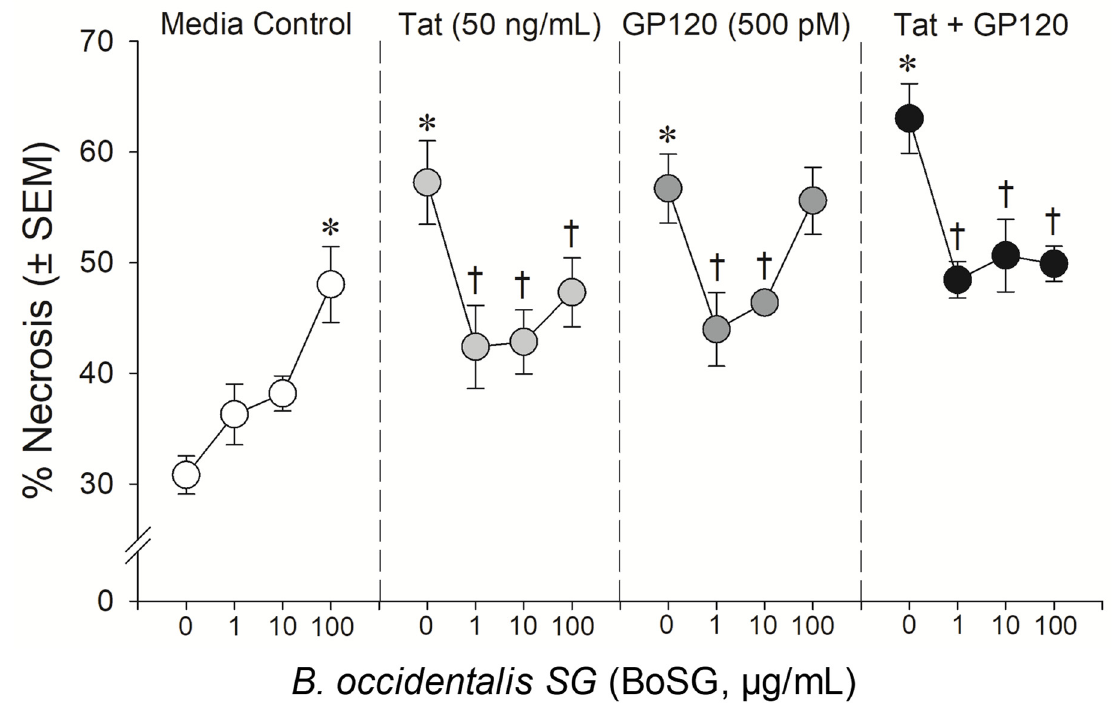
Figure 3. Neuronal cell death among C57BL/6N, striatal, medium spiny neurons co-exposed to Botryocladia occidentalis sulfated galactan (BoSG; 1, 10, and 100 μ g/mL), HIV-1 Tat (50 ng/mL), and/or HIV-1 gp120 (500 pM). * indicates significant increase in necrosis compared to untreated media control. † indicates significant protection from respective HIV-1 protein exposure. All points indicate the mean of 3–5 independent experiments (two-way ANOVA, p ≤ 0.05).